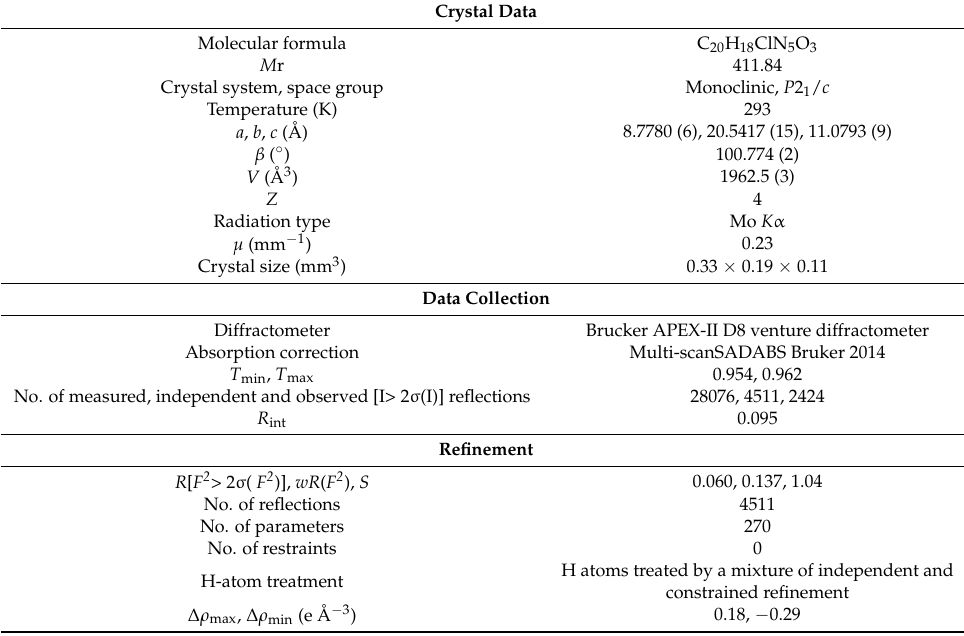
Table 1. X-ray experimental details of the semicarbazone 4